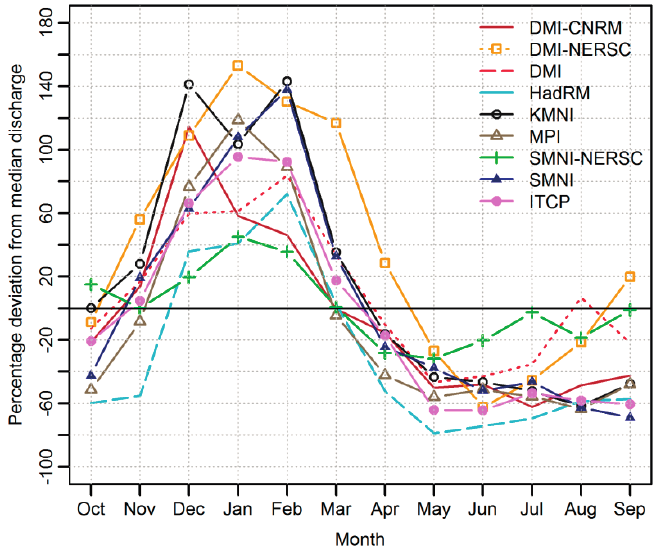
Figure 6. Deviation in monthly median discharge of Mures River for